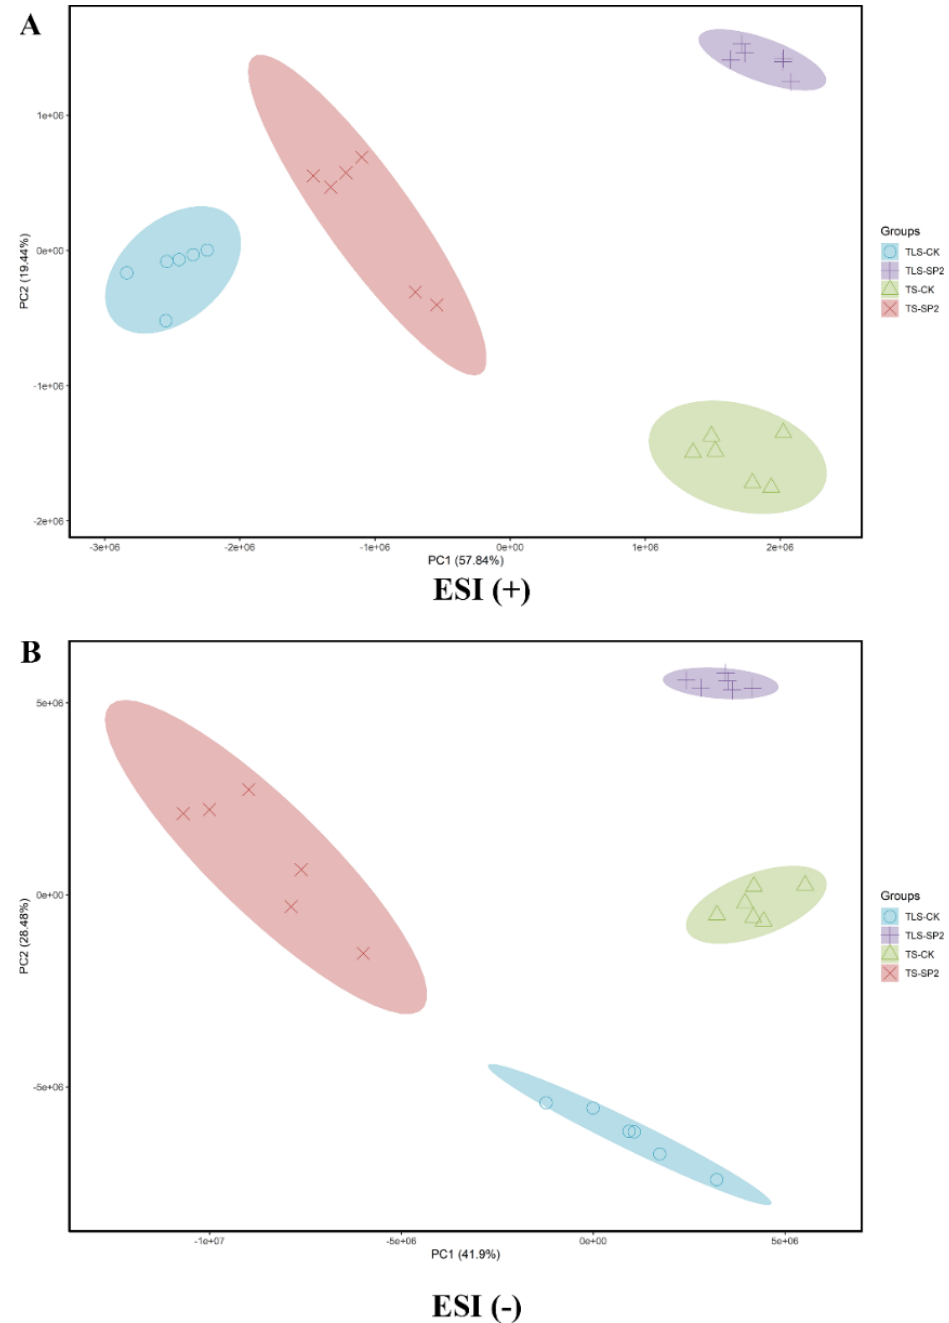
Figure 5. PCA score map of different rice sample groups based on UHPLC-QTOF/MS data (six biological replicates). ( A ) Positive ion mode, ( B ) negative ion mode; TLS and TS represent three leaf period and tillering stage. CK represents control group. SP2 represents the offspring of rice after spaceflight.